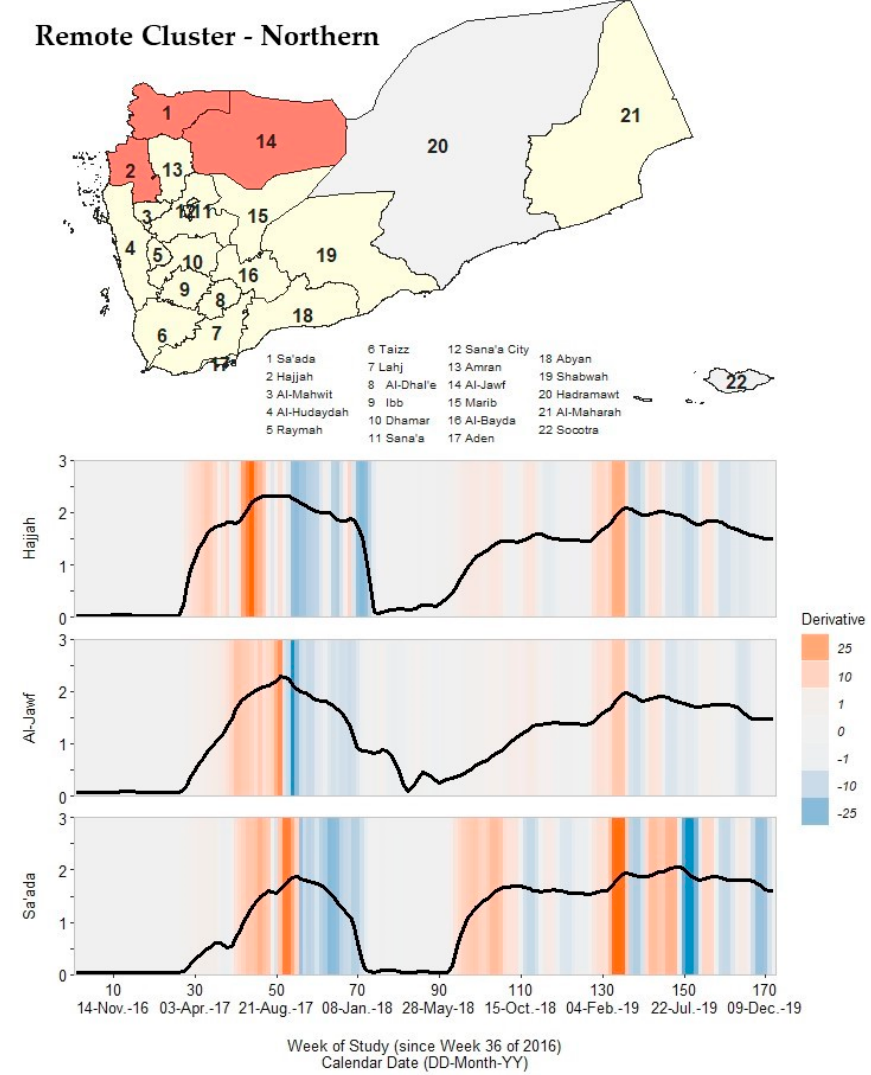
Figure 7. A map of Yemen with a shaded outbreak cluster including Hajjah, Al-Jawf, and Sa’ada, and a stacked time series plot and heatmap for each governorate’s outbreak signature. Top panel: the governorate-level map indicates governorates within the cluster in orange, remaining governorates within our study in yellow, and excluded governorates in grey (the Hadramaut and Socotra island governorate). Bottom panel: stacked time series plots for each governorate within the cluster. All plots show log10-transformed smoothed rates produced using Kolmogorov–Zurbenko adaptive filters from Week 36 (4–11 September) of 2016 through Week 52 (23–29 December) of 2019. Smoothed rates (laboratory-confirmed cholera cases per 100,000 persons) were estimated using the best per- forming smoother. Backgrounds for each plot are heatmaps of trivial derivative values, ranging from − 25 (dark blue) to +25 (dark orange) with values near zero in grey. Time series plots have a common horizontal axis of time reported in weeks since Week 36 of 2016 (defined as study Week 0). All rates and trivial derivates were calculated for the 172 weeks of time series. Data used to develop this visualization are reported in Table 1 and Supplementary Excel Table